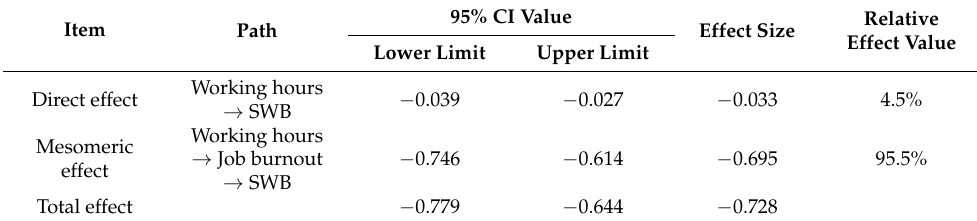
Table 5. Bootstrap test of significance of mediation